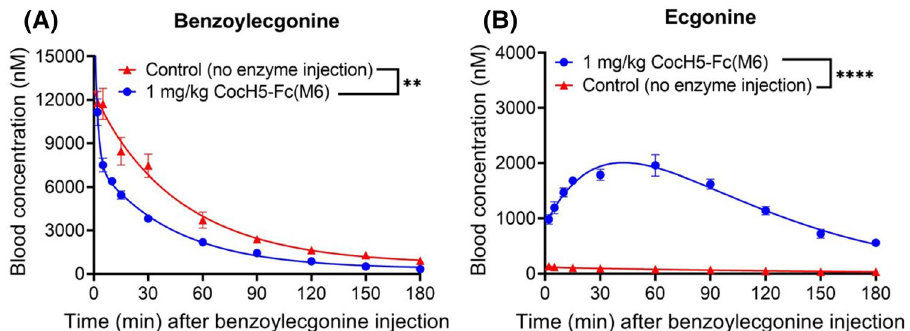
Figure 5. CocH5-Fc(M6)-accelerated clearance of benzoylecgonine in rats (n = 4 per group). Time-dependent concentrations of ( A ) benzoylecgonine and ( B ) ecgonine. The benzoylecgonine and ecgonine data for control (untreated rats) were reported previously 43 . Statistical significance (paired t test using the GraphPad Prism 8.0 software): * p < 0.05; ** p < 0.01; *** p < 0.001; **** p <